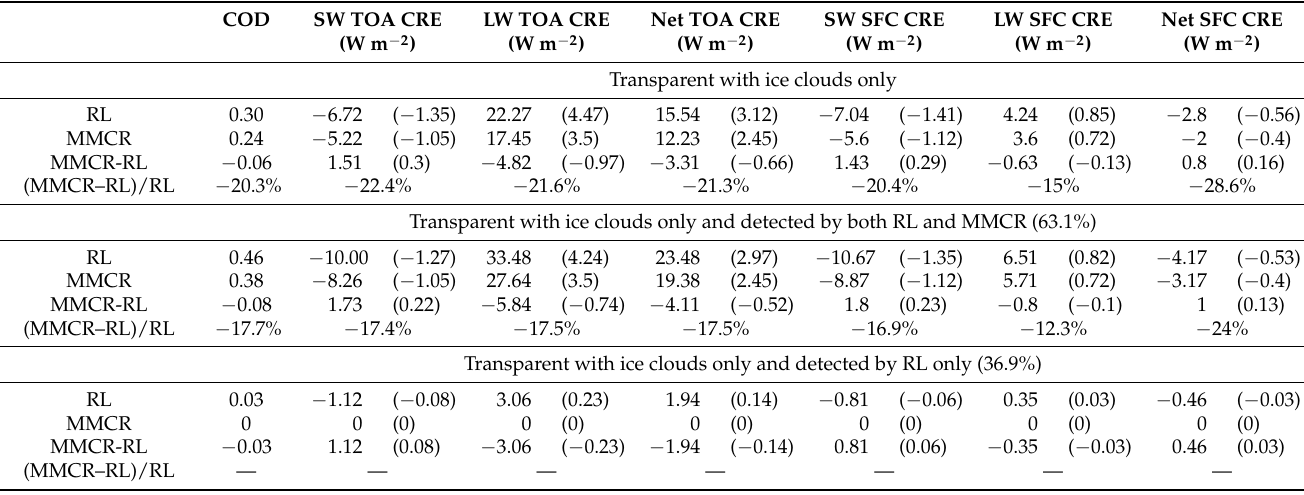
Table 1. Mean ice cloud optical depth (COD), and average shortwave (SW), longwave (LW), and net daily-mean cloud radiative effects (CREs, units: W m − 2 ) at the top of atmosphere (TOA) and surface (SFC) for transparent profiles with ice clouds only that are detected by the Raman lidar (RL) and millimeter wavelength cloud radar (MMCR) at the Southern Great Plains (SGP) site from August 2008 to January 2011. Absolute and relative differences for COD and CREs between the MMCR and RL are also shown. The climatic CREs, which are the CREs weighted by the occurrence fraction of RL transparent profiles with ice clouds only (i.e., 0.20), are given in the parentheses. The transparent profiles with ice clouds only are further partitioned into those detected by both RL and MMCR (63.1%) and those detected by RL only (36.9%). The climatic CREs for those detected by both RL and MMCR and those detected by RL only are also provided, weighted by the fraction of transparent with ice clouds only (i.e., 0.20) and their corresponding occurrence percentages (63.1% and 36.9%). LW TOA CRE